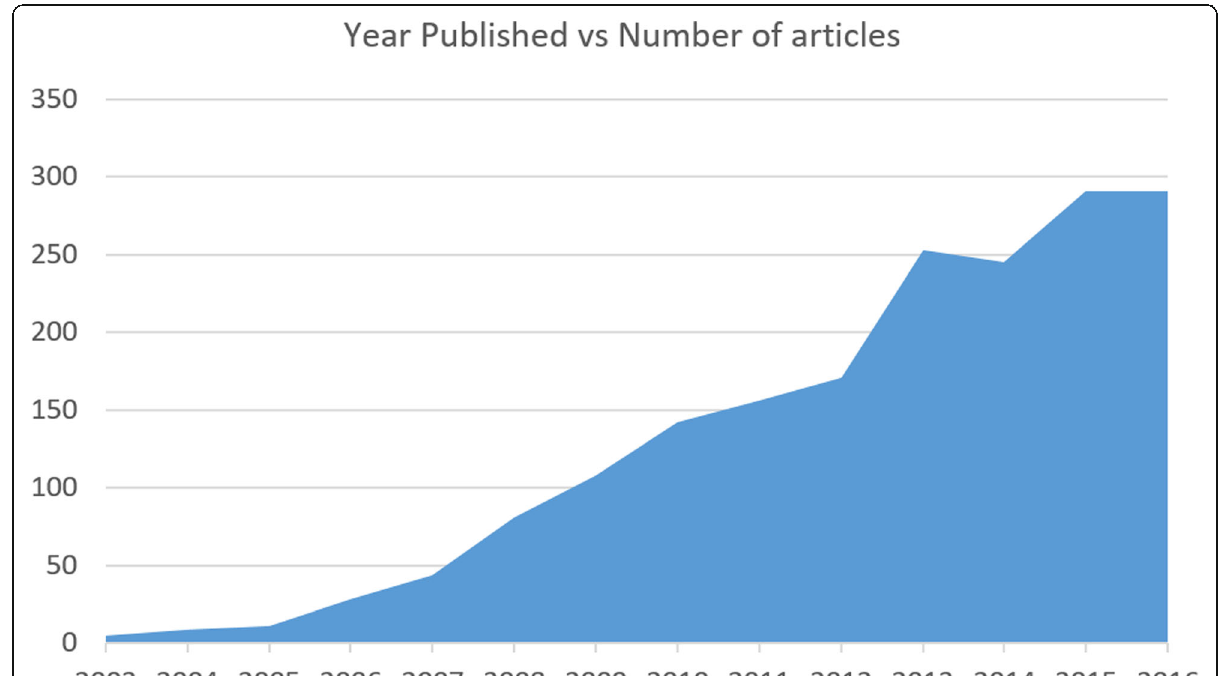
Fig. 1 Publication years sorted by the number of articles